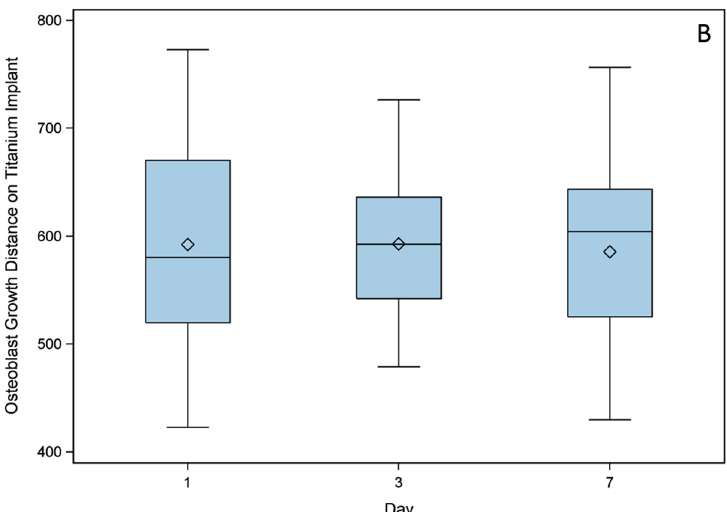
Figure 3. Cross sections were analyzed for changes in ( A ) total area of cell growth (µm 2 ) and ( B ) growth distance (µm) of osteoblasts from top–bottom pores at different time points (day 1, day 3, day 7). Osteoblast growth area was significantly higher on day 7 in comparison with day 1, whereas osteoblast growth distance was nearly the same over the seven